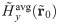
Sensor signal vs. bead position.Contour plots of the normalized sensor signal H˜yavg(r˜0) as function of bead position r˜0=(x˜0,y˜0,z˜0) for fixed z˜0=0.1. Calculations were carried out for a square sensor (ℓ = 1). Note, that global minima and maxima are found near the sensor edge (black frame) at y˜0=±0.5.